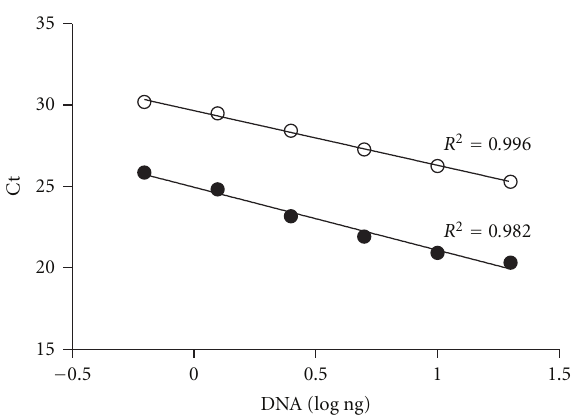
Figure 6: A standard curve generated from a reference DNA sample serially diluted by dilution factor 2 to produce six concentrations of DNA ranging from 0.625 to 20 ng of DNA per reaction. Shown inside are the correlation regression coe ffi cients ( R 2 ) of Ct versus the amount of DNA. Filled circles indicate telomeres and open circles indicate 36B4